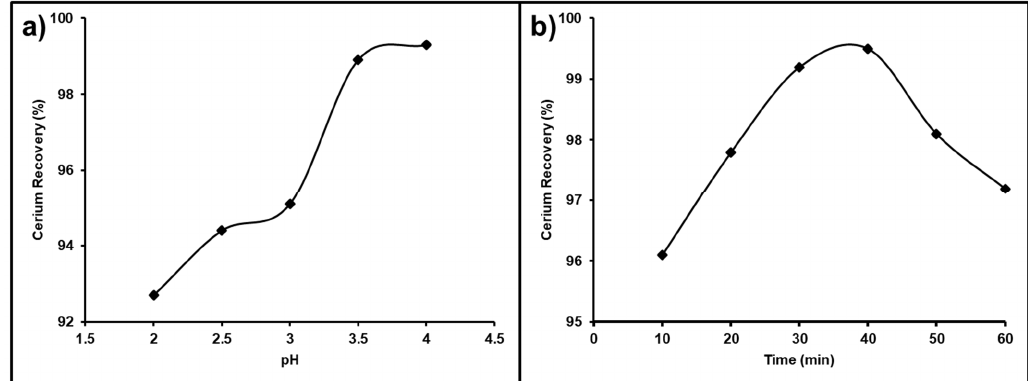
Figure 15. ( a ) Influence of pH; ( b ) influence of time on Ce separation from the REEs.